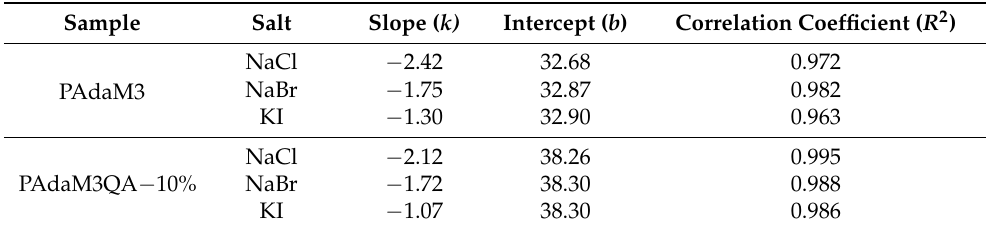
Figure 7. The effect of different ions on the LCST of ( a 1 ) PAdaM3 and ( a 2 ) PAdaM3QA − 10% solutions; the fitting curve between the ion concentration and the LCST of ( b 1 ) PAdaM3 and ( b 2 ) PAdaM3QA − 10% solutions. Table 3. The parameters of the fitting curves for LCST ion concentrations of PAdaM3 and PAdaM3QA − 10%